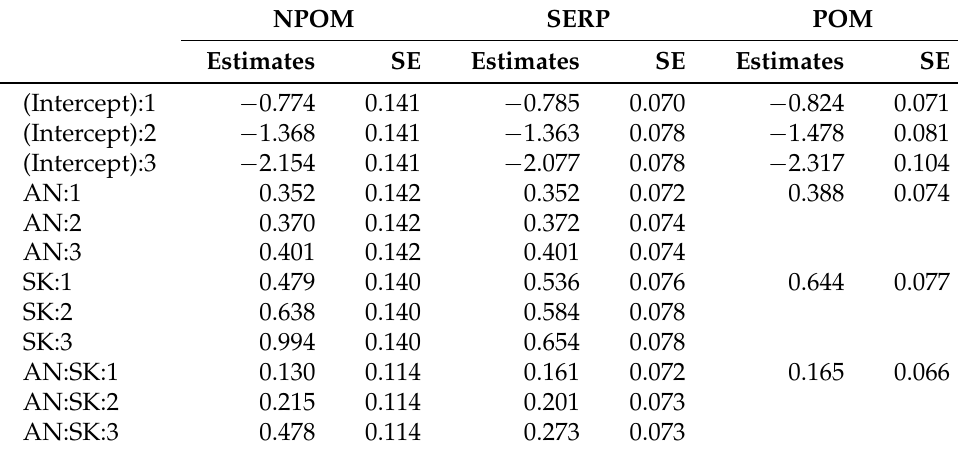
Table 2. Estimates and standard errors (SE) of regression coefficients in SERP and (N)POM for the sensory rating of panelist G, with androstenone (AN), skatole (SK) and interaction (AN:SK) as predictors of deviant smell.